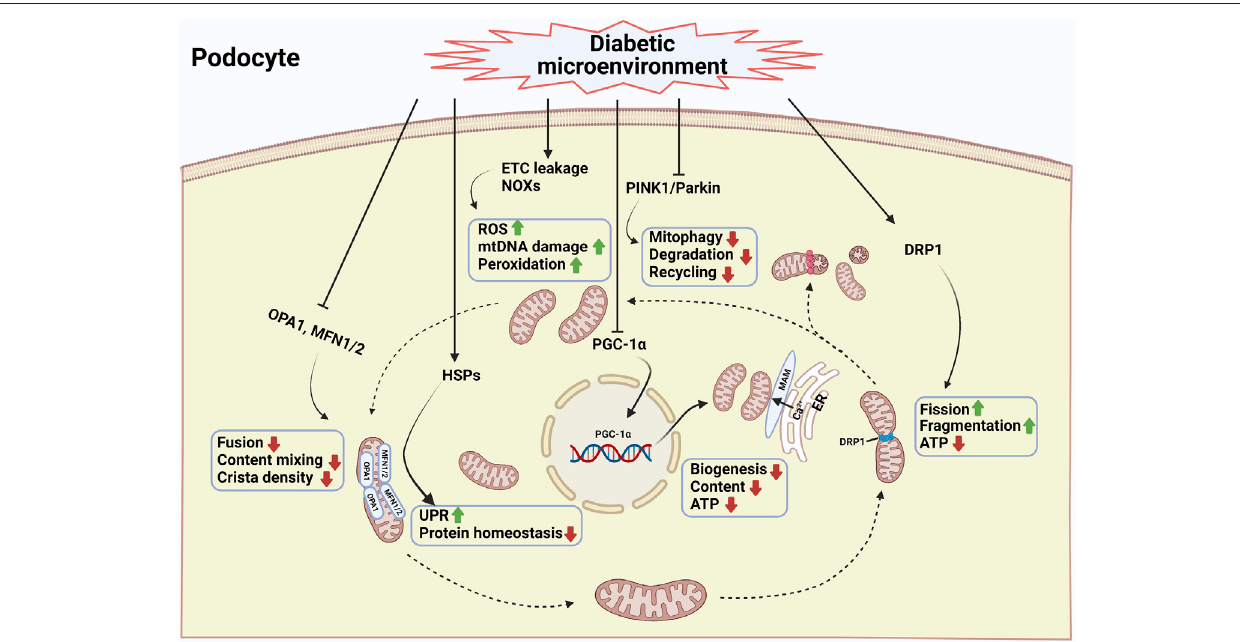
FIGURE1| Mitochondrialdamageofpodocytesduringdiabetickidneydisease.Mitochondriaarehighlydynamicorganellesthatrespondtopathophysiologiccues by altering mitochondrial content, fusion, fi ssion, mitophagy, and the unfolded protein response. Fission and fusion complement each other to maintain mitochondrial morphology, whereas mitophagy selectively clears damaged mitochondria from the network (Nisoli et al., 2004). Excessive mitochondrial fi ssion combined with decreased mitochondrial fusion is a prototypical feature of podocytes in diabetic kidney disease (Wang et al., 2012; Ayanga et al., 2016; Qin et al., 2019; Audzeyenka et al., 2021). In addition, the inhibition of mitophagy leads to the lack of a proper mitochondrial turnover in the diabetic kidney (Li et al., 2016; Li W. et al., 2017).Another keyfeatureofmitochondrialdysfunctionofpodocytesindiabetickidneydiseaseisthereducedef fi ciencyofmitochondrialbiogenesis(Sunetal.,2014;Li S.-Y. et al., 2017; Zhang et al., 2018). Under high glucose condition, intracellular ROS production, mitochondrial DNA damage and protein and lipid peroxidation were enhanced (Tan et al., 2010; Dugan et al., 2013; Coughlan et al., 2016). In addition, mitochondrial protein homeostasis is challenging because of the continuous exposure of mitochondrial proteins to mitochondrial ROS. Mitochondria within a cell cannot exist in isolation. They interact with endoplasmic reticulum via the formation of mitochondrial-associated membranes (MAMs). The disturbance of MAMs leads to abnormal intracellular Ca 2+ in fl ux, mitochondrial damage, and apoptosis (Inoue et al., 2019). A combination of the above factors resulted in podocyte injury and the progression of diabetic kidney disease. The podocyte mitochondria in diabetic condition is illustrated schematically with blue frame and text. DRP1, dynamin-1-like protein; MFNs, mitofusin proteins 1 and 2; ETC, electron transport chain; HSPs, heat shock proteins; MAM, mitochondria associated ER membrane; NOXs, NADPH oxidases; OPA1, optic atrophy protein 1; PGC-1 α , peroxisome proliferator activated receptor γ coactivator-1 α ; PINK1, PTEN-induced putative kinase protein 1; ROS, reactive oxygen species; UPR, unfolded protein response (Created with